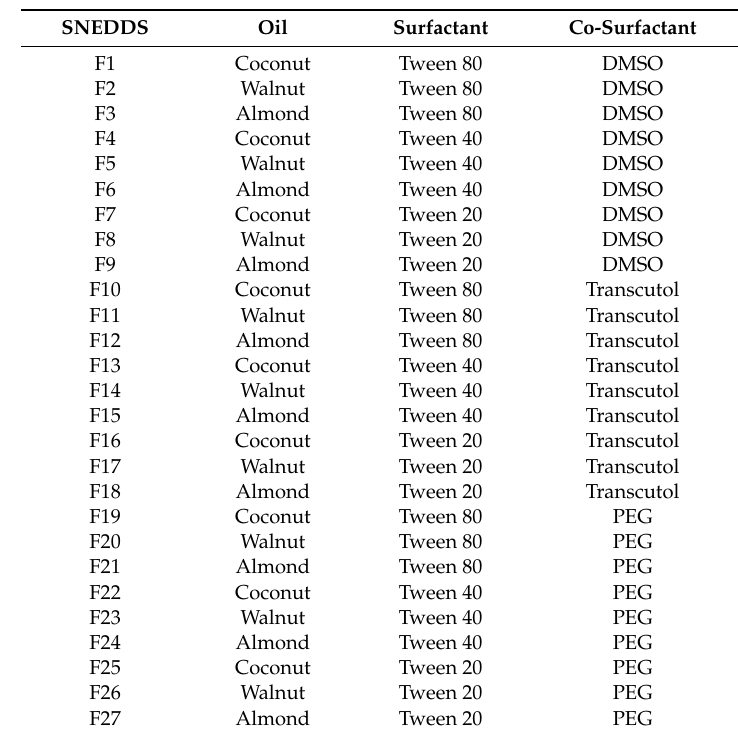
Table 7. The screening and optimization of the designation of self nano-emulsifying drug delivery system (SNEDDS).